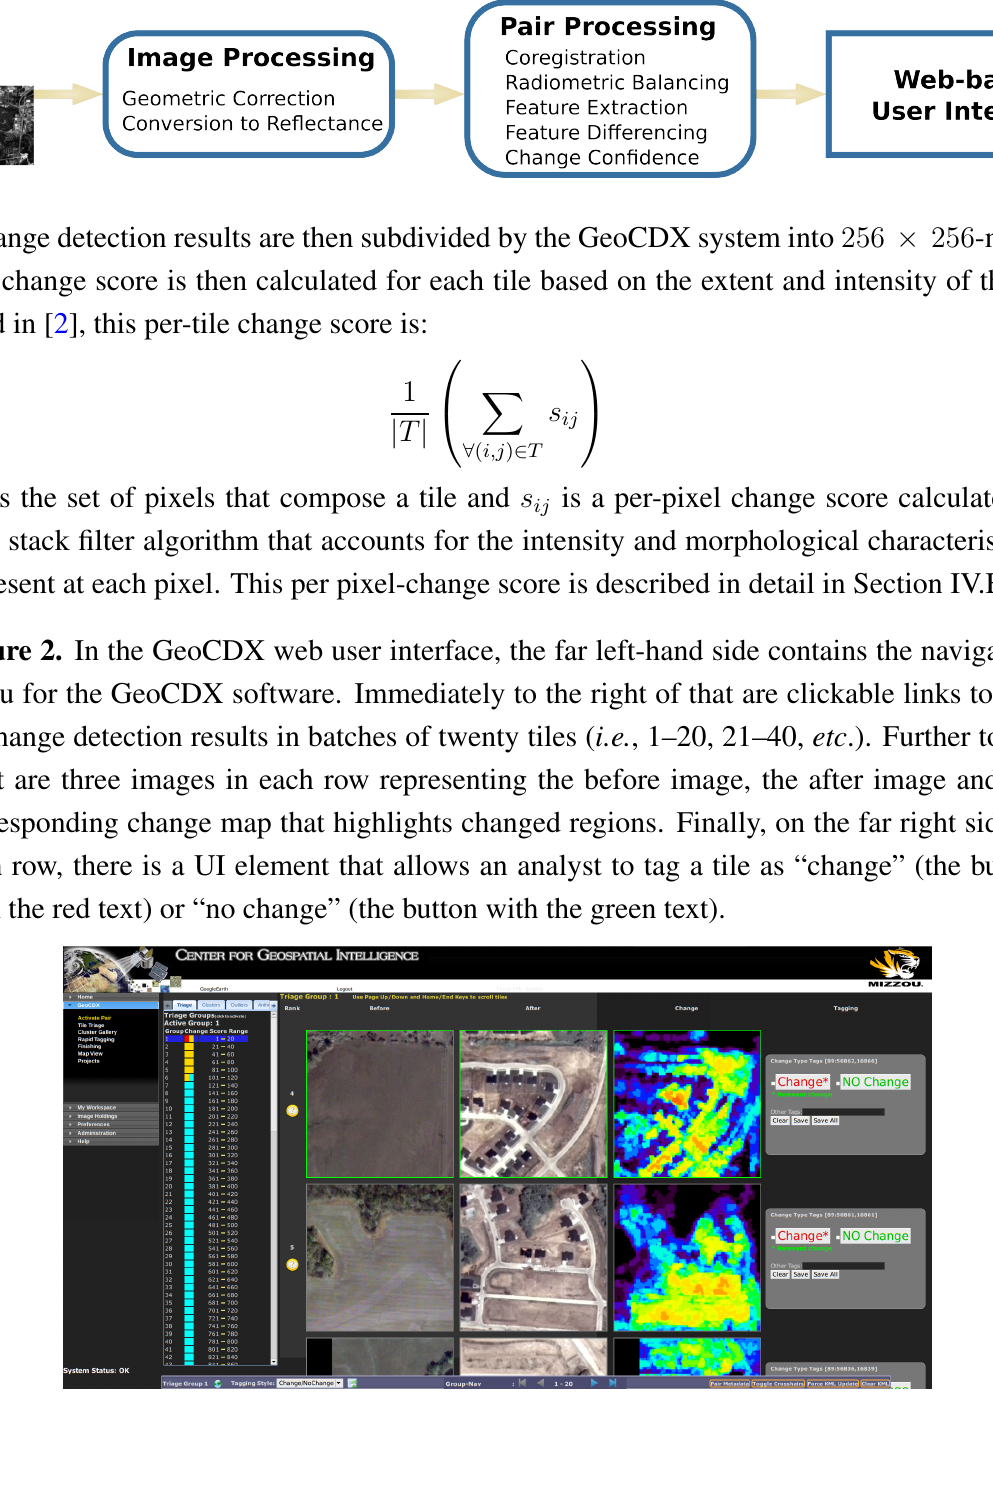
Figure 1. A high-level overview of the Geospatial Change Detection and Exploitation System (GeoCDX) processing flow.